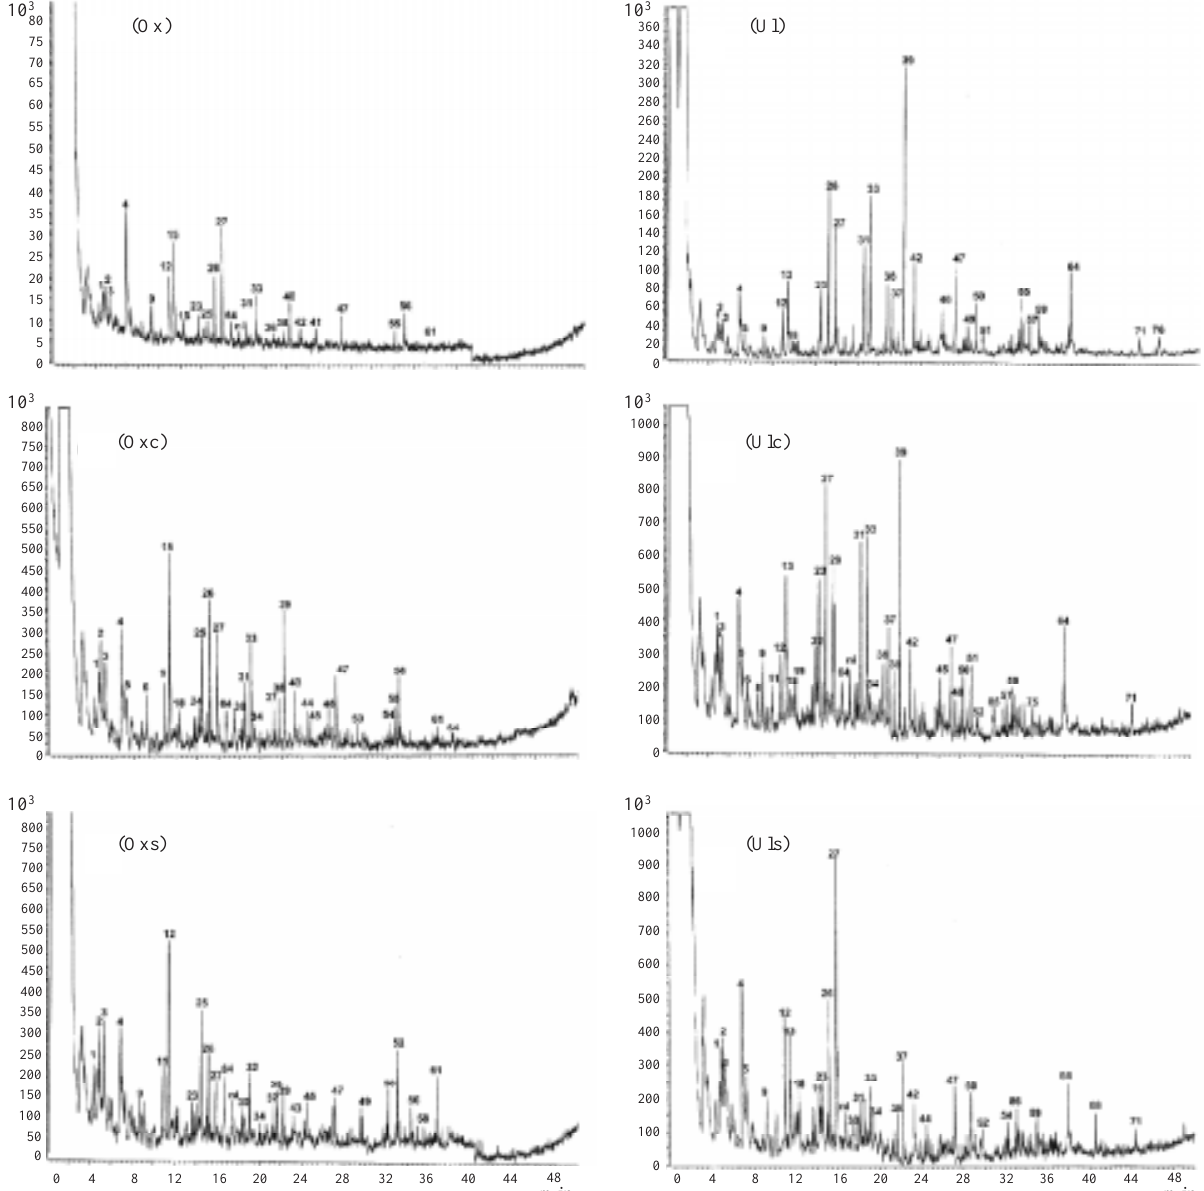
Figure 1. Py-GC/MS profile of humic acids isolated from Oxisol (Ox) Oxisol plus compost (Oxc) Oxisol plus sewage sludge (Oxs), Ultisol (Ul), Ultisol plus compost (Ulc), and Ultisol plus sewage sludge